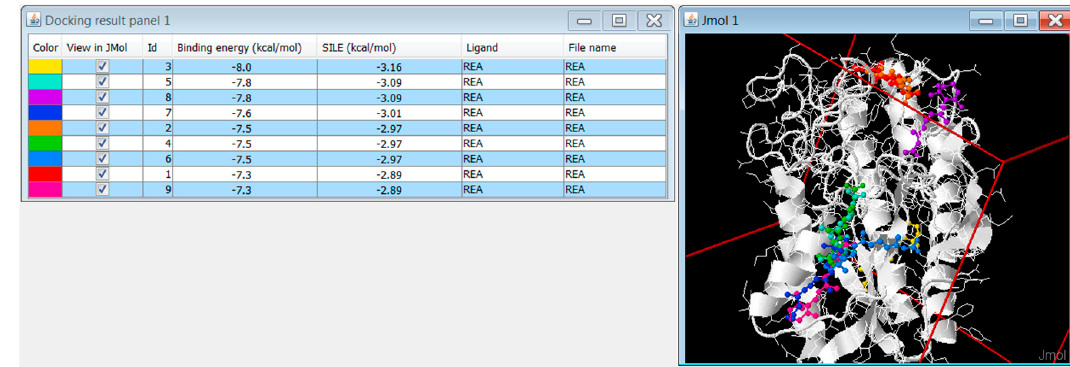
Figure 4. Screenshot of DockingApp RF’s output window, displaying the predicted binding energy values of the novel scoring function, along with the SILE (Size-Independent Ligand Efficiency [27]) values.